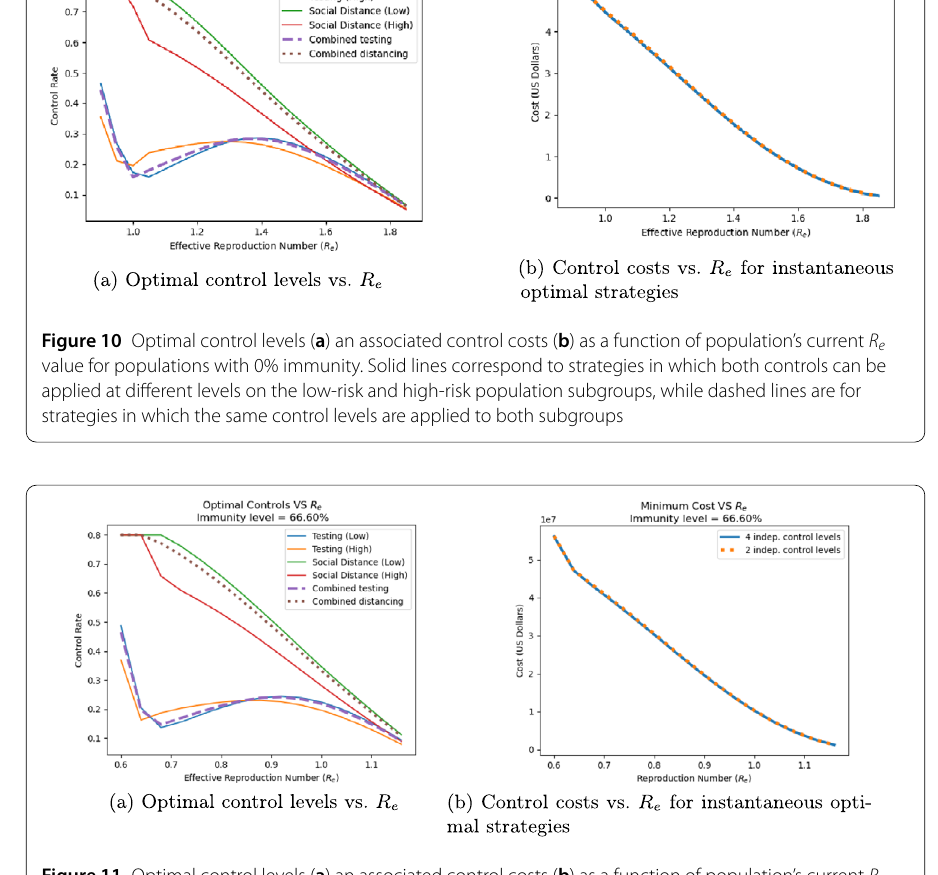
When four controls are allowed to vary independently, social distancing for the low-risk subpopulation is applied at a higher level than for the high-risk subpopulation. This is due to the fact that according to (3) low-risk individuals have greater contact rates, and thus are more influential in spreading the disease. However, when the same level of control is applied to both low and high risk subpopulations, the costs are nearly the same as shown in Figs. 10(b) and 11(b). This indicates that costs are not highly sensitive to the specific strategies